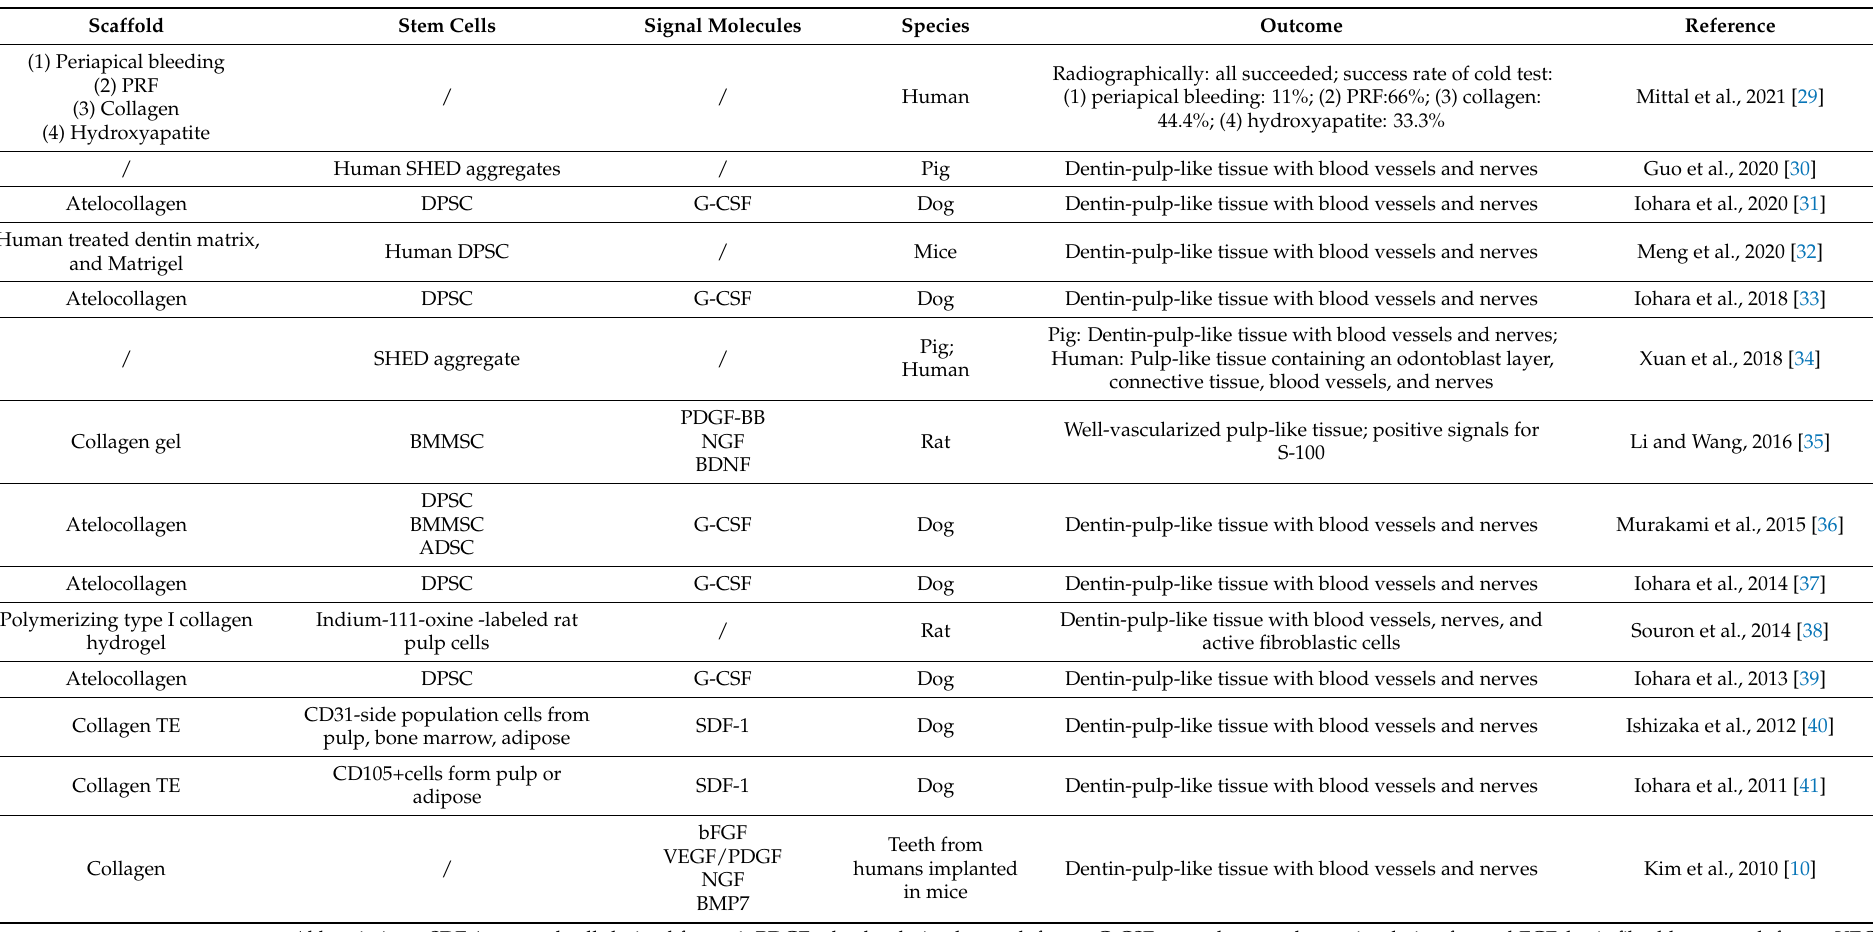
Table 1. Summary of the characteristics of neural regeneration in vivo, including animal and clinical studies of cell homing and stem cell implantation.